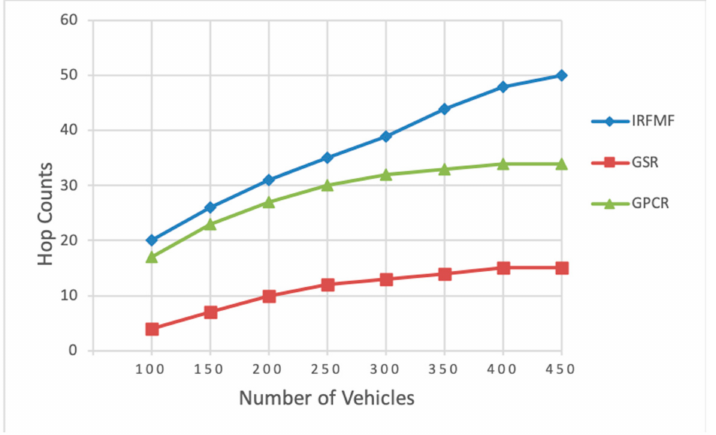
Figure 5. Comparison chart of average hop count of the three protocols with different numbers of vehicles.